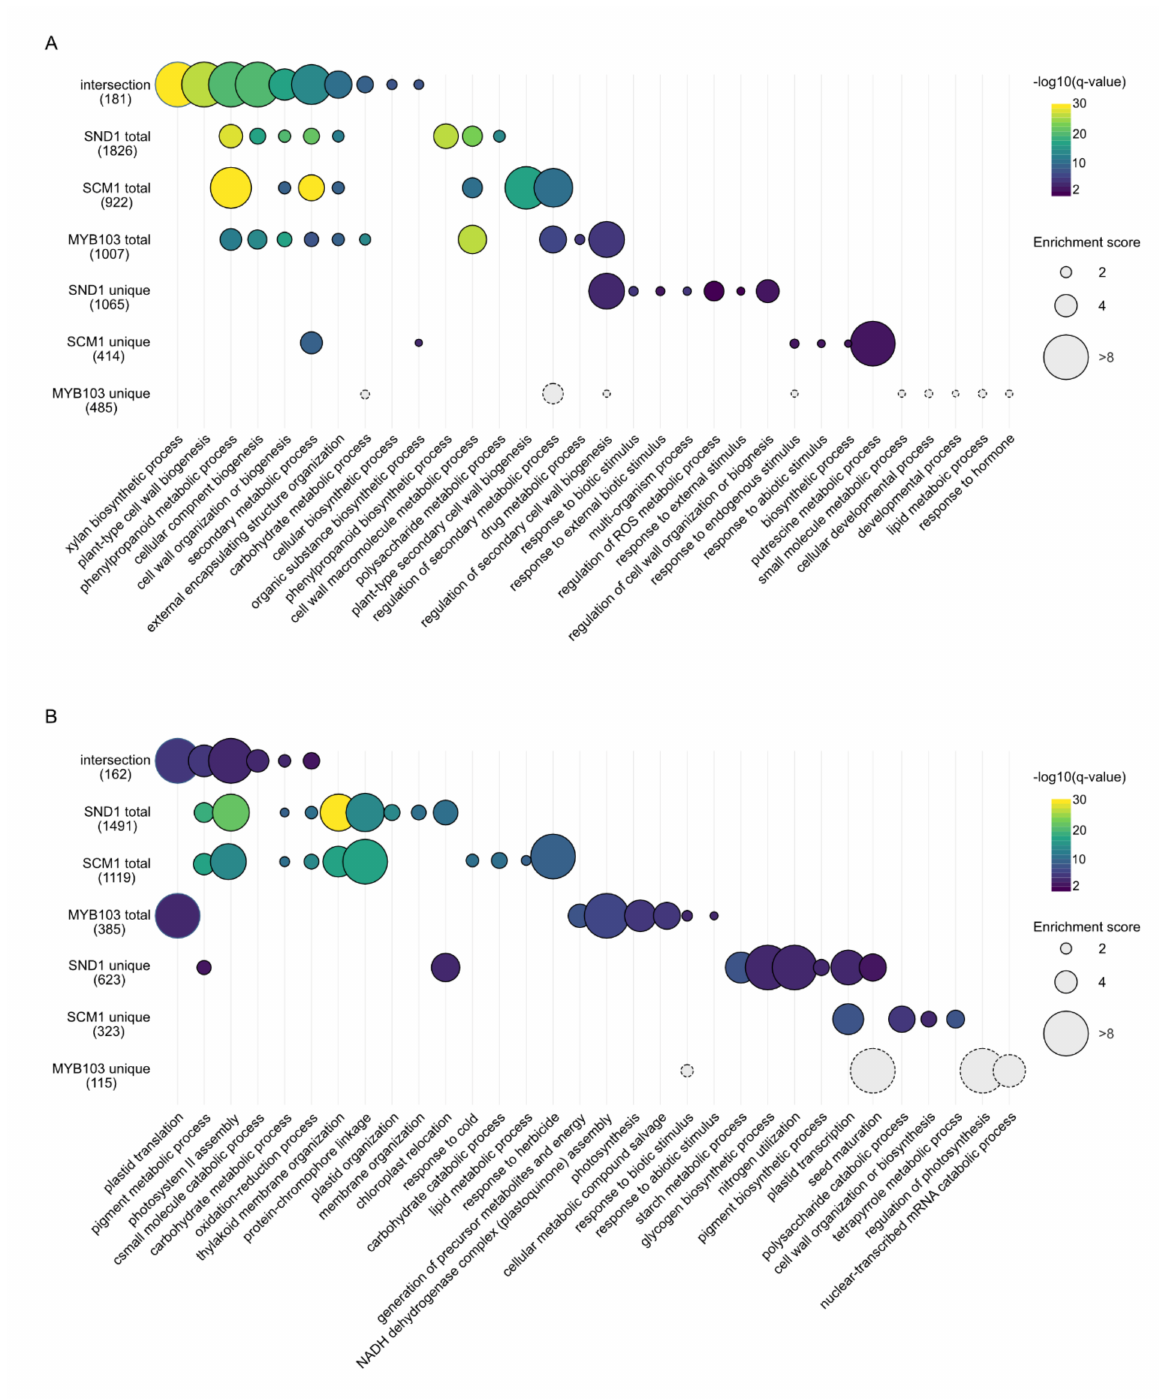
Figure 5. Bubble plots indicating shared and distinct GO terms enriched in different sets of DEGs. ( A ) Upregulated DEGs. ( B ) Downregulatd DEGs. Colors represent the − log 10 transformation of the adjusted p -value ( q -value), the size of the circles represents enrichment score of the corresponding GO term. Enrichment score is calculated by dividing the percentage of genes associated with a given GO term in the respective DEG list by the percentage of associated genes in the genome. Dashed circles indicate non-significant enrichment based on adjusted p -values. The ten most significantly enriched GO terms in each DEG list were used to construct the plot. Categories represented by fewer than three genes were excluded. See Tables S2 and S3 for complete